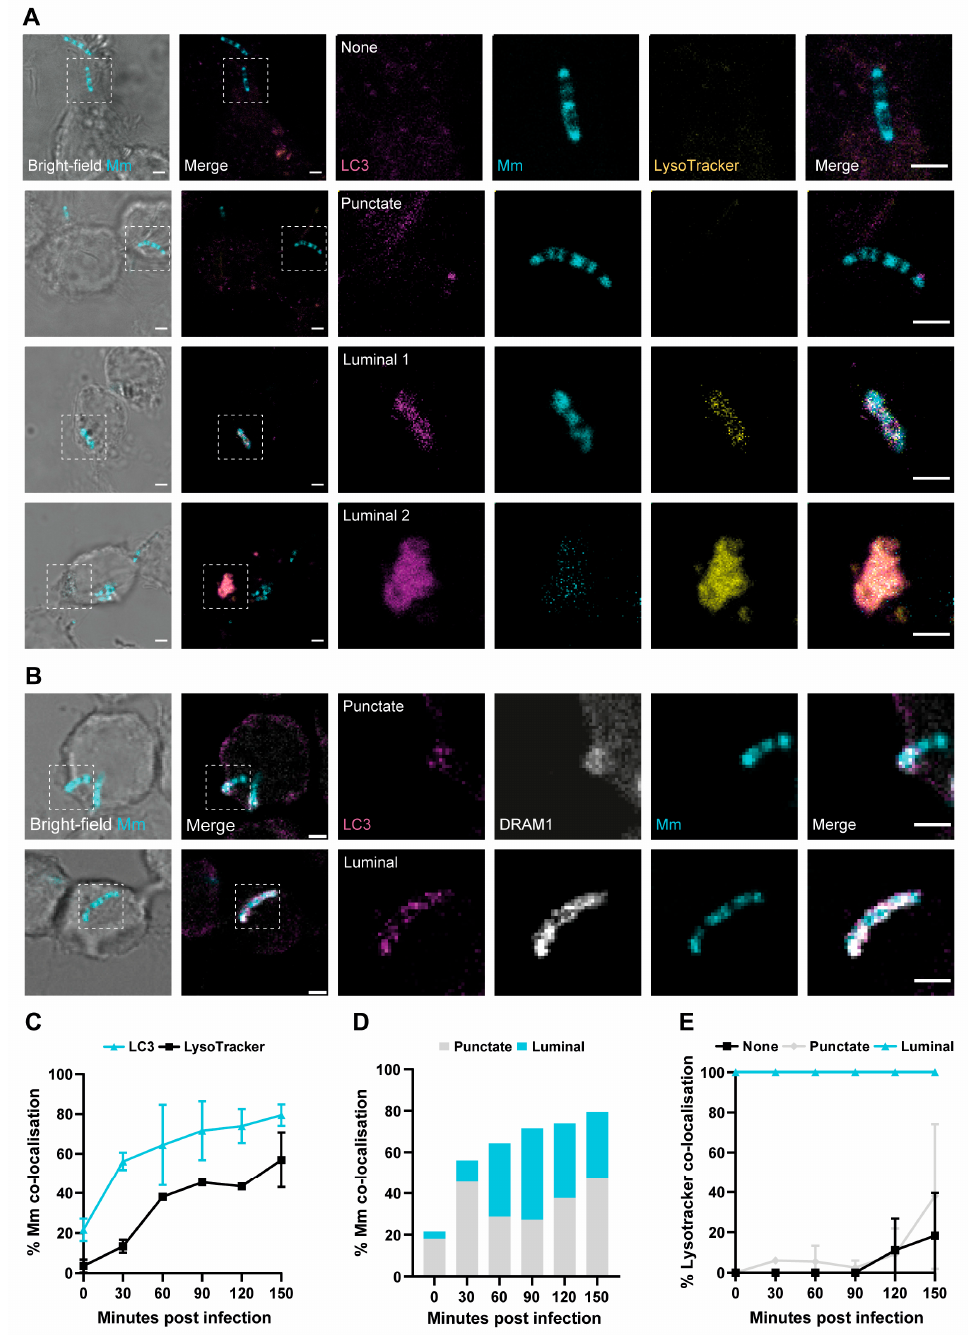
Figure 2. Acidified mycobacteria-containing vesicles are labelled by LC3. ( A ) Representative exam- ples of LC3 (magenta) colocalisation patterns with Mm (cyan), referred to as punctate and luminal patterns. An example of LC3-negative Mm (none) is also shown. Acidification of Mm -containing vesicles was assessed by LysoTracker staining (yellow). Scale bars: 2 µm. ( B ) Representative exam- ples of the double colocalisation of LC3 (magenta) and DRAM1 (grey) with Mm (cyan). Scale bars: 2 µm. ( C ) Frequency of Mm colocalisation with LC3 or LysoTracker over time. ( D ) Frequency of Mm colocalisation with LC3 in punctate or luminal patterns over time. ( E ) Frequency of LysoTracker colocalisation with LC3-negative Mm and LC3-positive punctate and luminal Mm patterns over time. Data were accumulated from two independent experiments with the following total numbers of Mm observations per time point: 99 for t = 0, 129 for t = 30, 96 for t = 60, 124 for t = 90, 133 for t = 120 and 127 for t = 150 min.